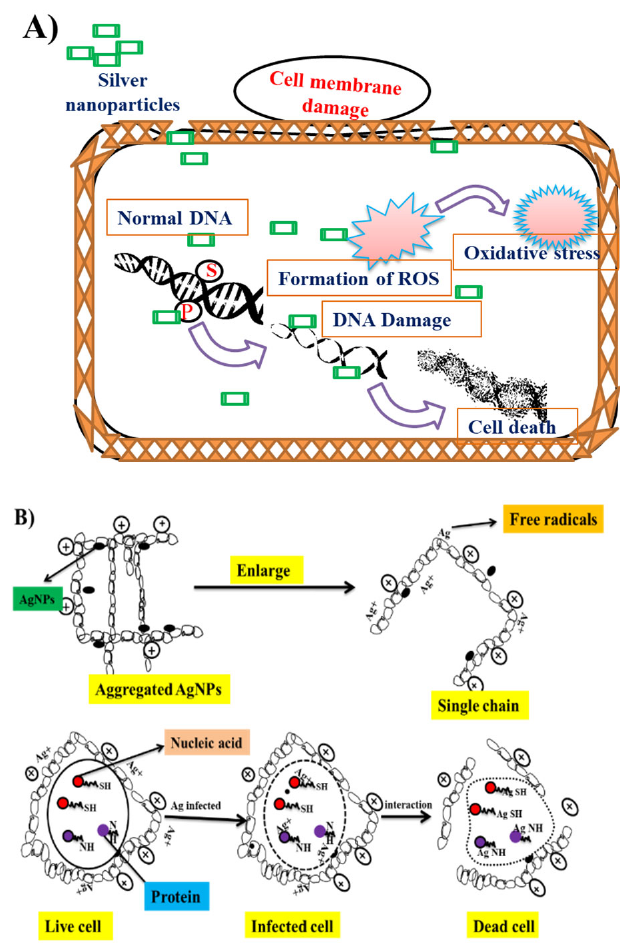
Figure 6. ( A ) Diagrammatic representation of the action of silver nanoparticles against bacteria; ( B ) detailed schematic representation of mechanical interactions of AgNPs with bacteria, including aggregation, generation of free radicals, infection with bacterial nucleic acids and amino groups, and bacterial cell damage.